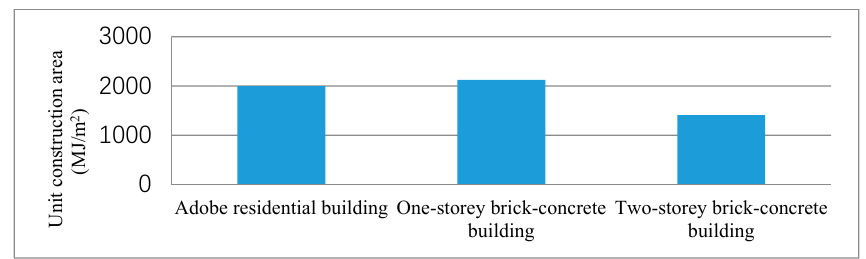
Figure 11. Energy demand of unit construction area in the process of building use.